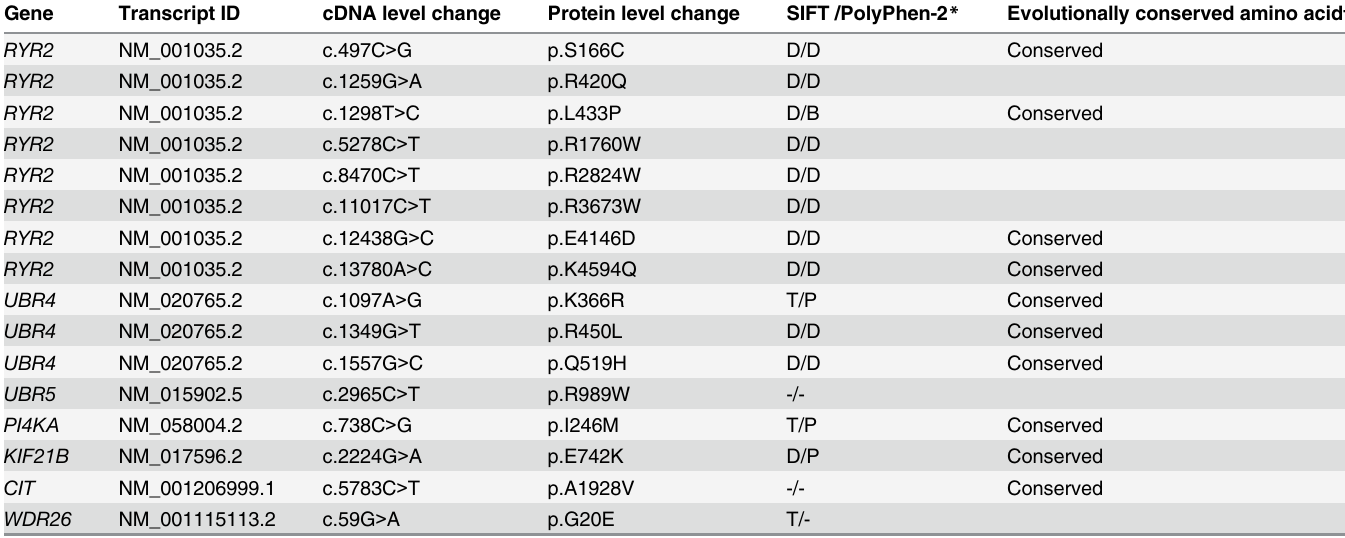
Table 5. Candidate mutations in independent unrelated